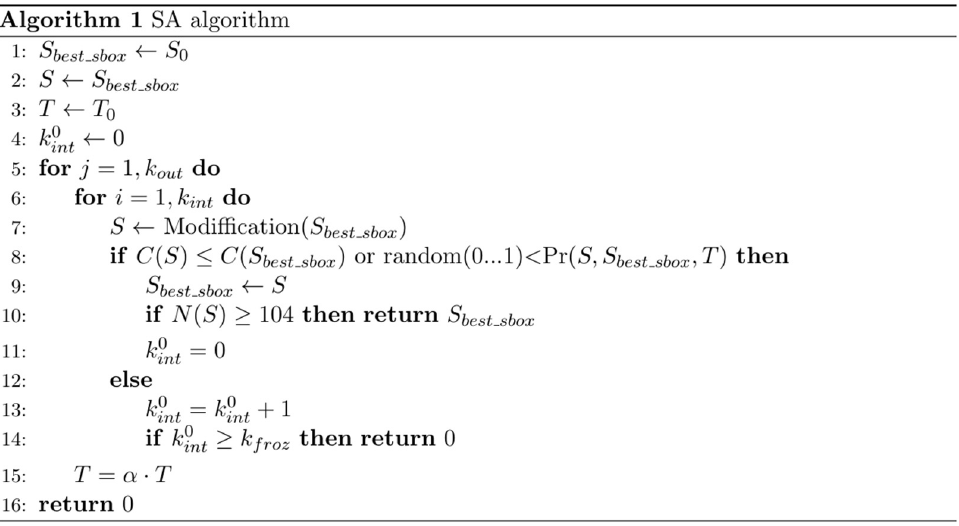
Figure 1. Pseudocode of the proposed annealing simulation algorithm.